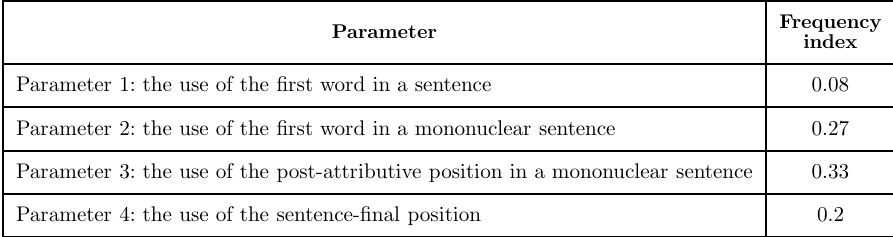
Syntactic parameters and the indices of their figurative noun